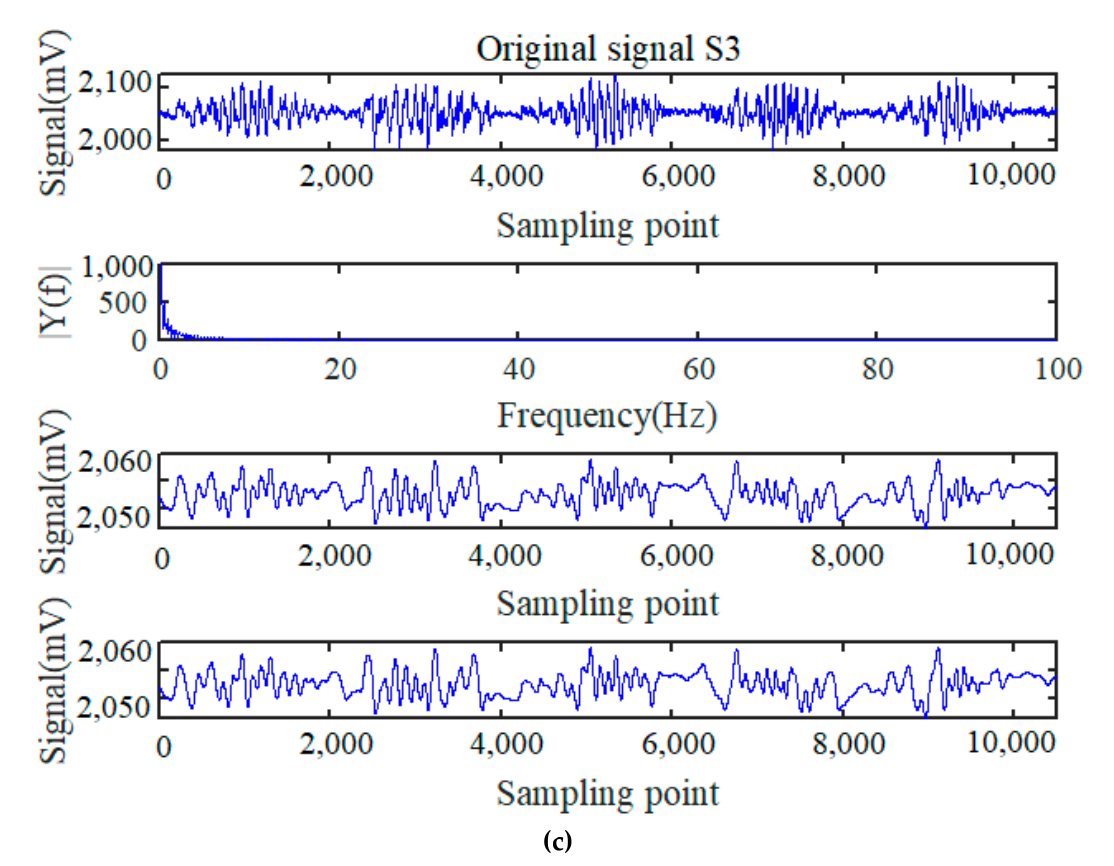
Figure 5. Weak signals processed by lowpass filtering and wavelet denoising. ( a ) Lowpass, FFT spectrum and wavelet denoising of wire rope signal S1. ( b ) Lowpass, FFT spectrum and wavelet denoising of wire rope signal S2. ( c ) Lowpass, FFT spectrum and wavelet denoising of wire rope signal S3.